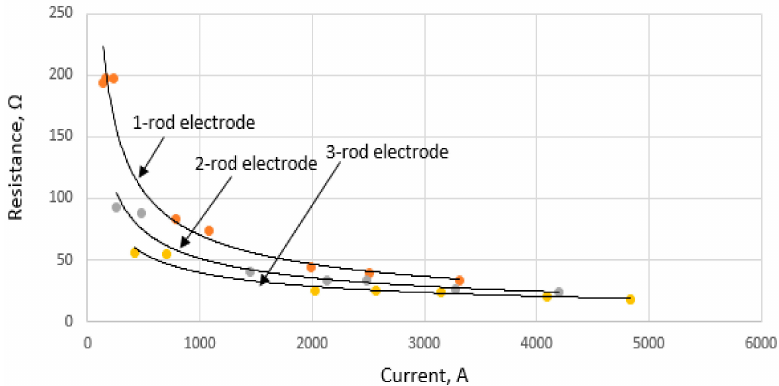
Figure 24. Impulse resistances for 1-rod, 2-rod and 3-rod